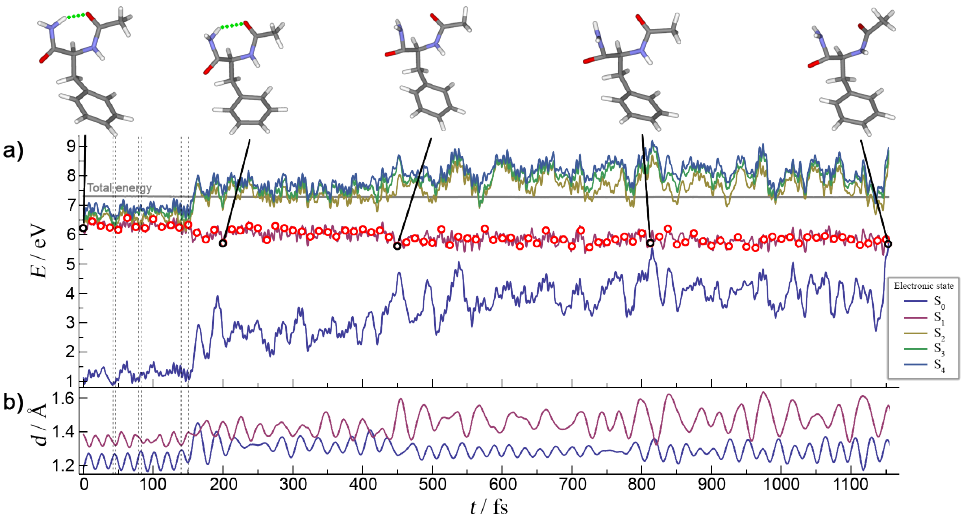
Figure 5. ( a ) Time evolution of the ground and four lowest excited adiabatic electronic states along the trajectory exhibiting Mechanism II. The red circles designate the currently-occupied state. Insets show selected geometries along the trajectory (black circle). Vertical dashed lines indicate the occurrence of trajectory surface hops. The energies are relative to the NAPA conformer B minimum energy; ( b ) The change of C Phe =O (blue) and C Phe –N (bordeaux) bond lengths along the